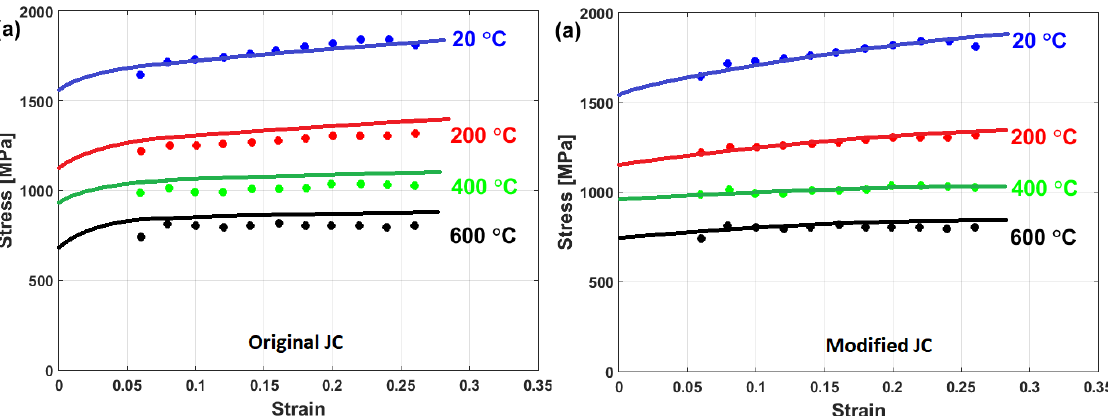
Figure 41. Experimental stresses (markers) compared to predicted stresses (solid lines) for Ti-6Al-4V alloy under hot deformation using ( a ) the original JC model and ( b ) the modified JC model that was presented by Hou X. et al. [87].